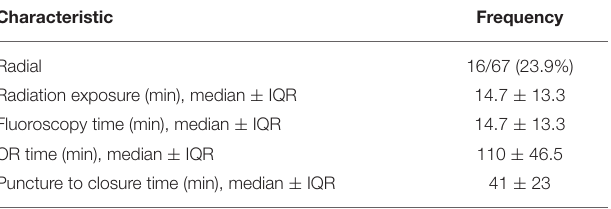
TABLE 2 | Procedure